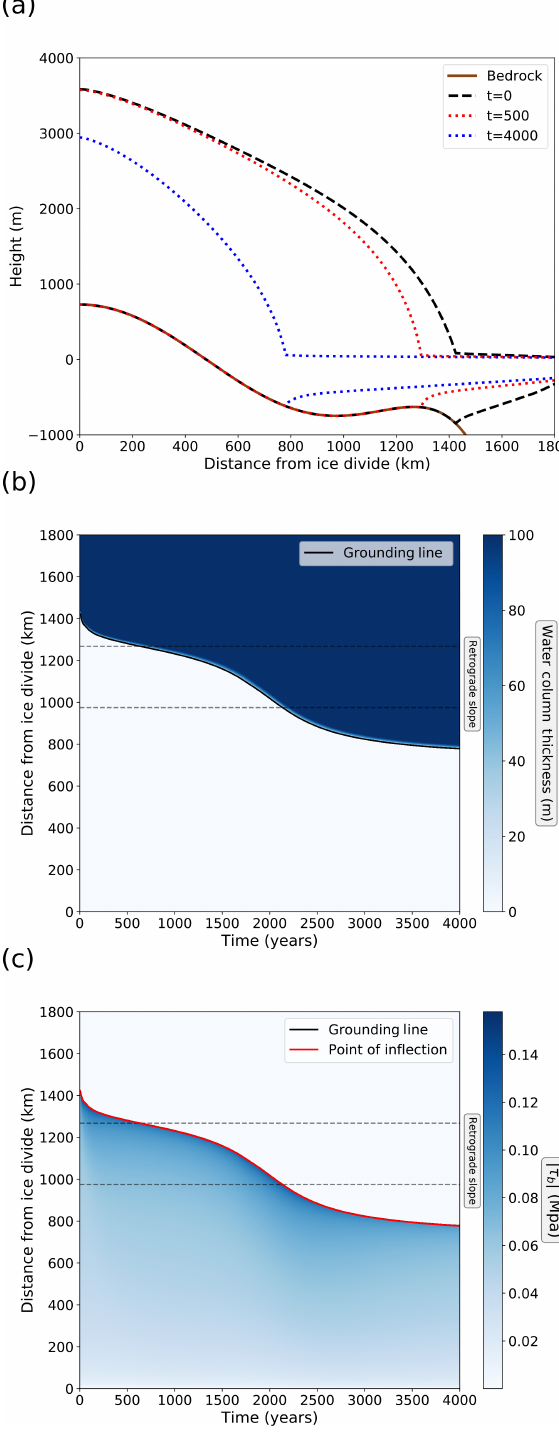
Figure 4. Retreat experiment details with the Weertman sliding relation and W = 400km. (a) Ice sheet profiles during retreat. Bedrock profile is also shown. (b) Evolution of the water column thickness during retreat. (c) Evolution of the basal shear stress. Note that the point of inflection and grounding line position are co-